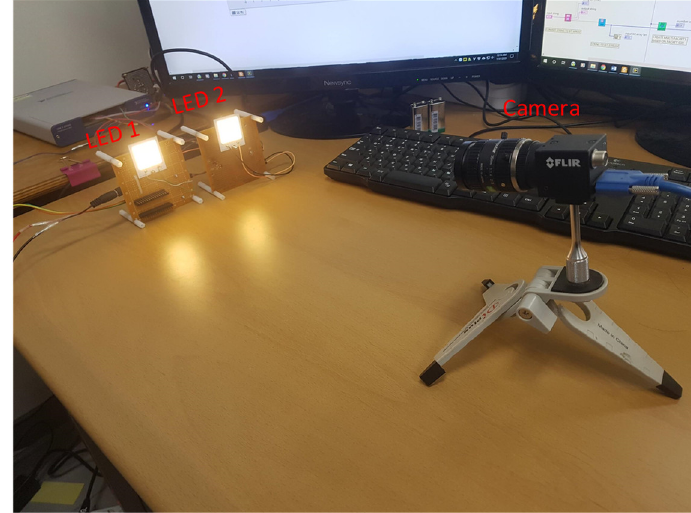
Figure 15. The experiment implementation environment.